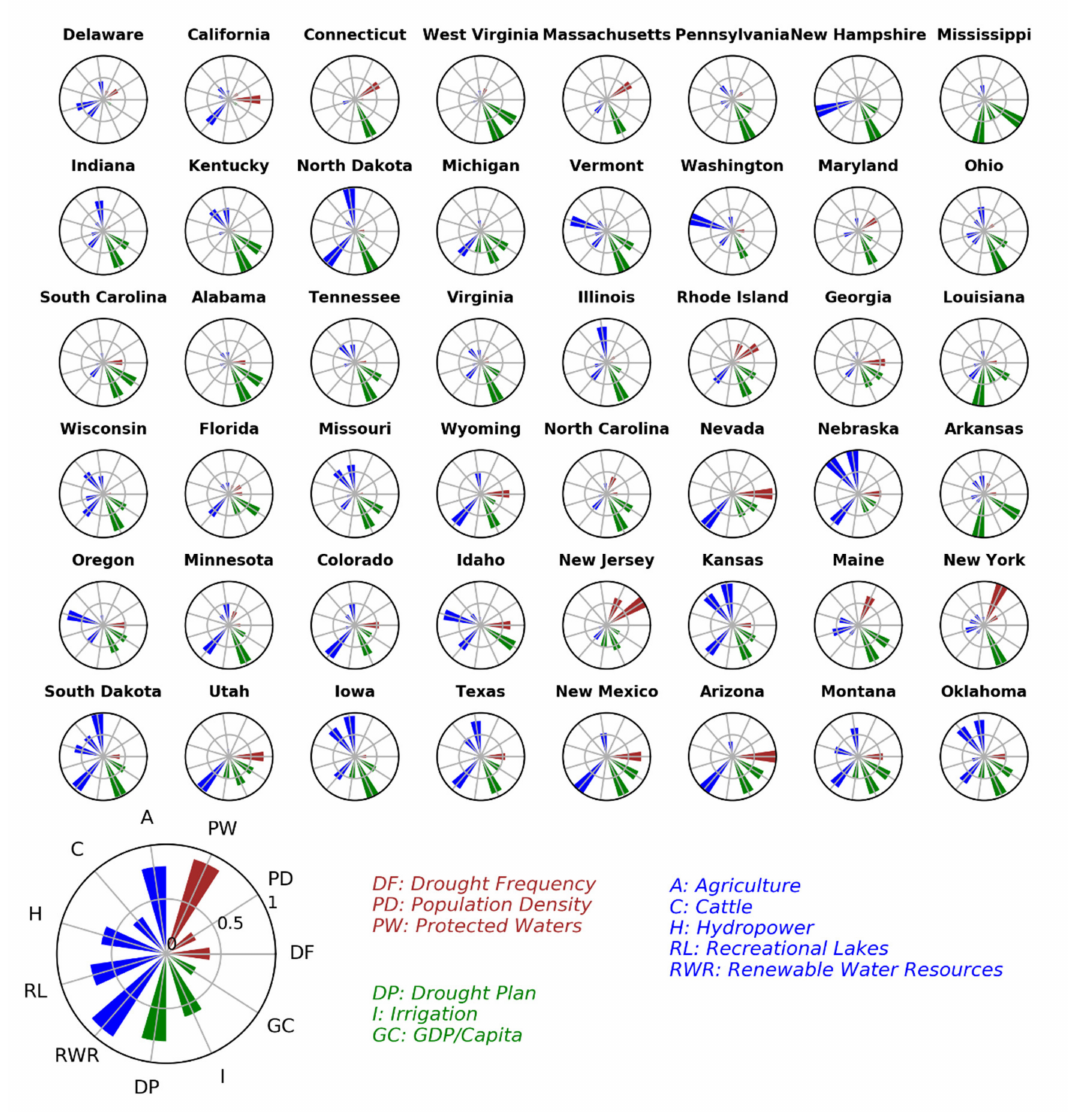
Figure 2. Contribution of the eleven drought indicators for the contiguous U.S. states. The brown, blue, and green colors refer to the indicators of exposure, sensitivity, and adaptive capacity,